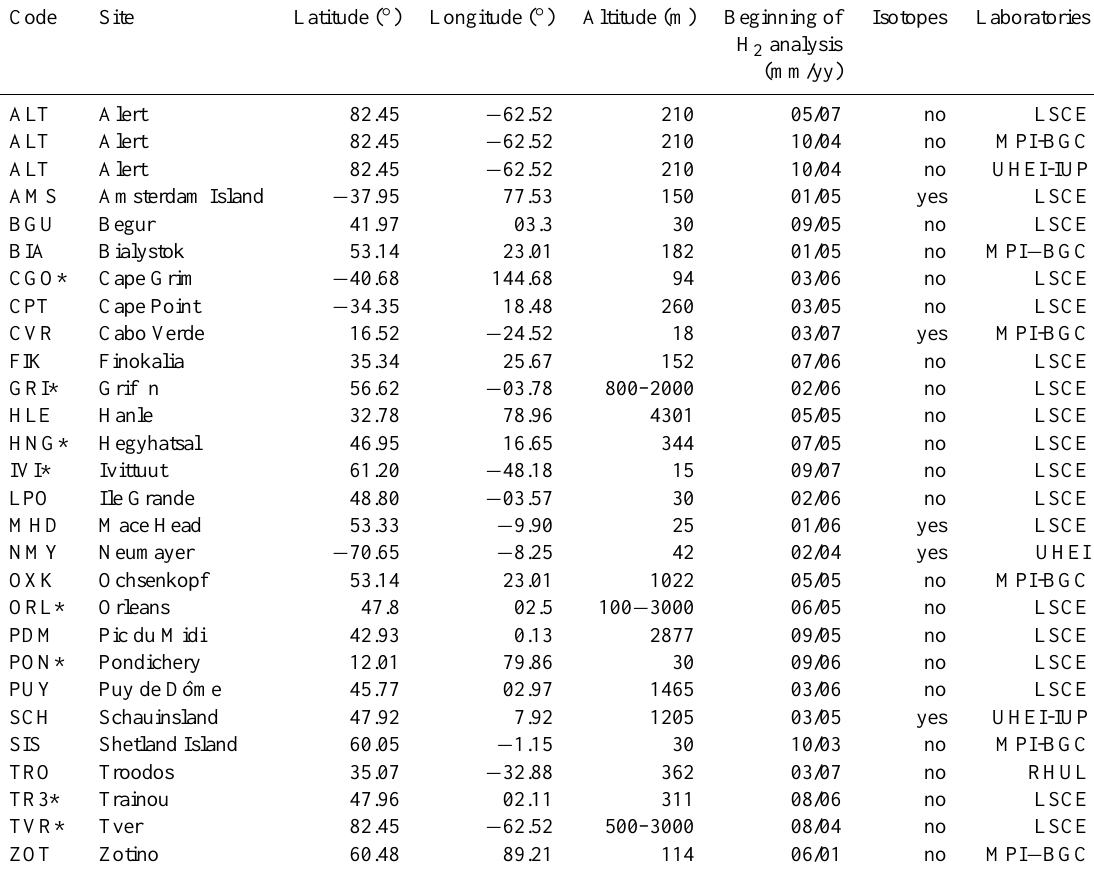
Table 1. Flask sampling network sites ( ∗ RAMCES network (LSCE) sites additional to EUROHYDROS network). LSCE: Laboratoire des Sciences du Climat et de l’Environnement, France; MPI-BGC: Max Planck Institut f¨ur Biogeochemie, Germany; RHUL: Royal Holloway, University of London, UK; UHEI-IUP: Universit¨at Heidelberg, Institut f¨ur Umweltphysik,